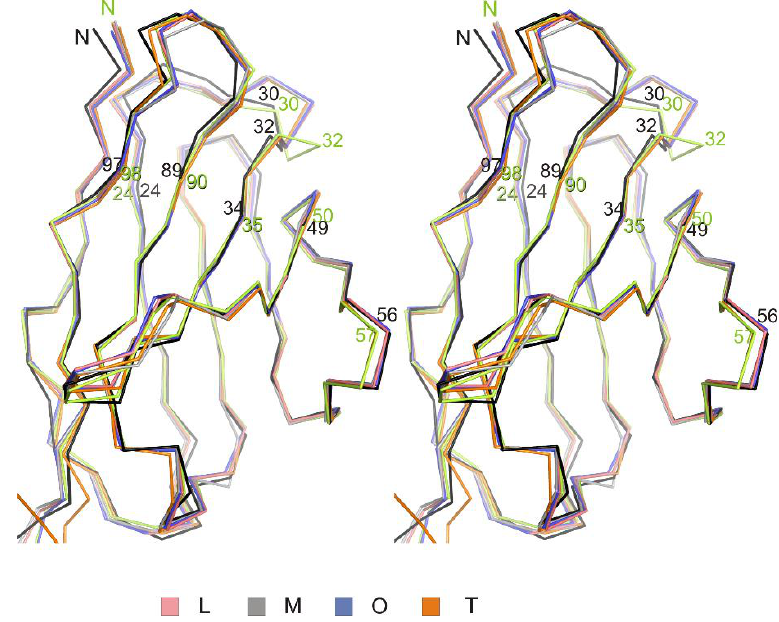
Figure 4. Structural alignment of variable domains of light chains. A stereo view of structural alignment of Cα chains of variable domains of the four netakimab Fab molecules (L,M,O,T) and corresponding regions of light chains of antibodies, whose structures have similar structural organization of the CDR regions (green: human germline antibody IGHV5-51/IGKV3-20; black: FV from human IGM immunoglobulin).